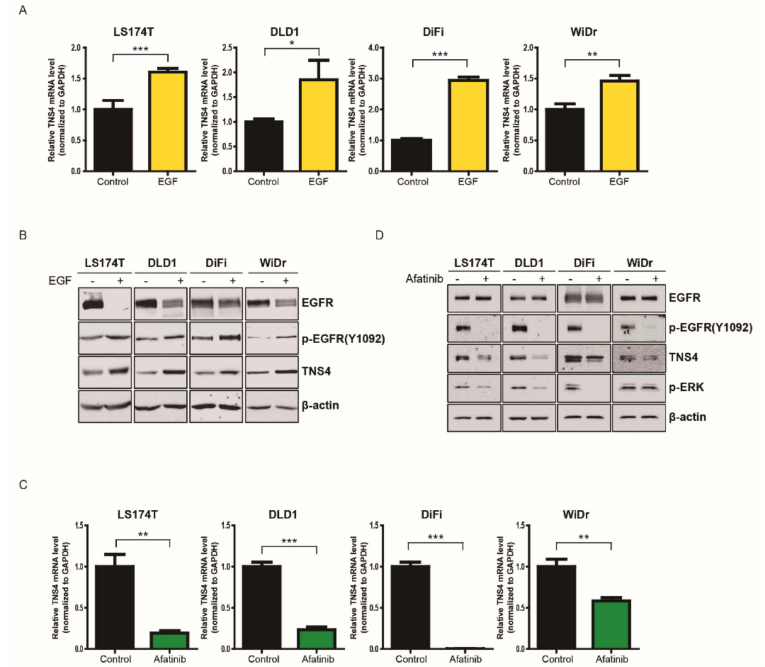
Figure 2. Expression of TNS4 in colon cancer cell lines are transcriptionally regulated via EGFR signaling pathways. ( A , C ) Quantitative PCR analysis was carried out using primer sets targeting TNS4 on total mRNA isolated from LS174T, DLD1, DiFi and WiDr cells treated without (control) or with either EGF (10 ng / mL) for 12 h ( A ) or afatinib (1 µ M) for 24 h. The bar graphs show the relative TNS4 mRNA levels of EGF-treated samples were normalized to control (*, p < 0.5; **, p < 0.01; and ***, p < 0.001). ( B , D ) Cell lysates prepared from LS174T, DLD1, DiFi and WiDr cells with or without EGF ( B ) or afatinib treatment ( D ) were subjected to immunoblotting analysis with antibodies against total EGFR or phospho-EGFR (Y1092), TNS4, phospho-ERK and β